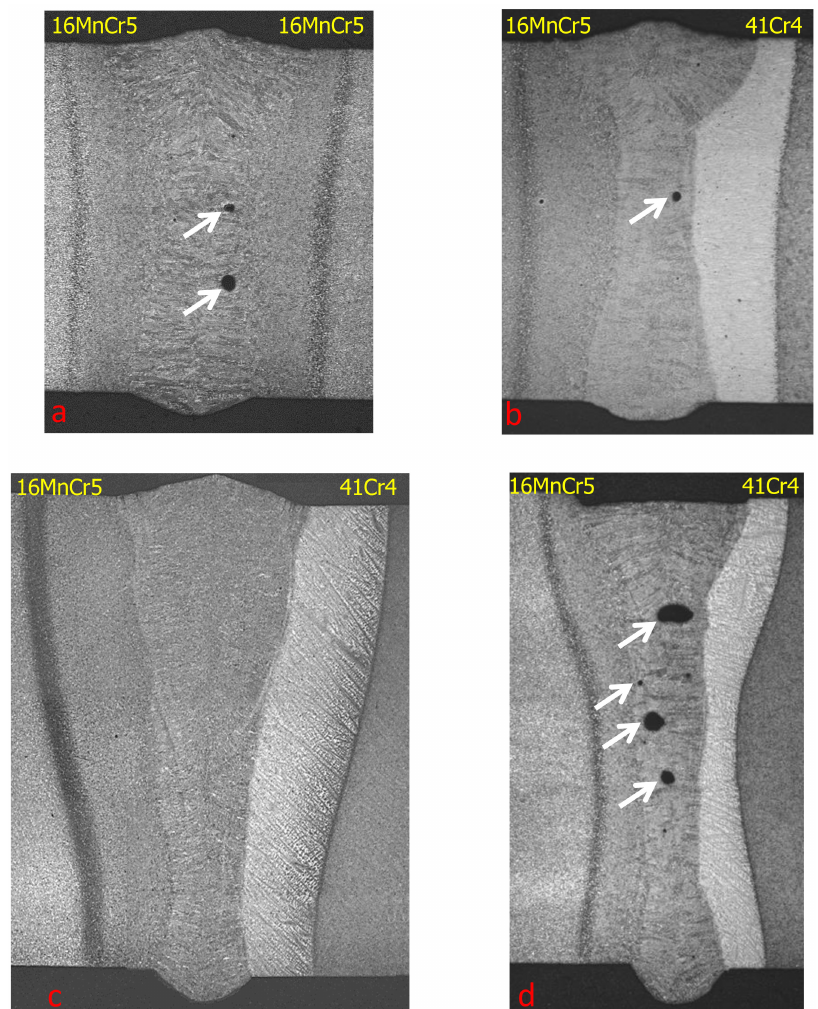
Figure 5. Cross section of laser welded samples for the indicated material combinations and the following laser systems and sample thicknesses: ( a – b ) 4 kW Nd:YAG laser and 5 mm sample thickness, ( c – d ) 6 kW CO 2 laser and 8 kW fiber laser system with 8 mm sample thickness. The presence of pores is highlighted in the arrowed regions within the